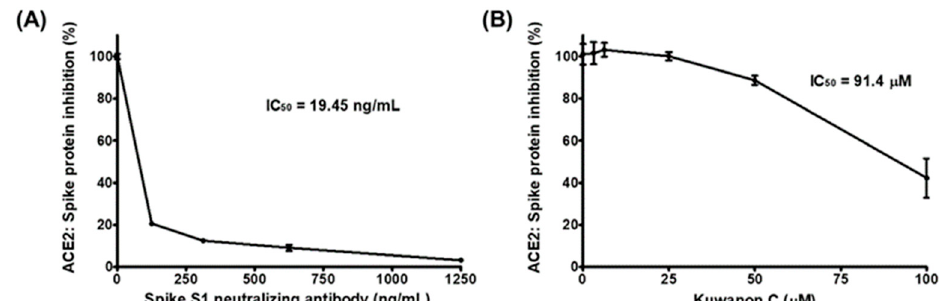
Figure 1. The inhibition of the interaction between the spike protein S1 receptor-binding domain (RBD) and the human angiotensin-converting enzyme 2 (ACE2) receptor by kuwanon C (KC). Spike protein coated on a 96-well plate interacted with a preincubated mixture of the ACE2 receptor and ( A ) anti-SARS-CoV-2 spike S1 antibody as the positive control and ( B ) 0, 3.125, 6.25, 12.5, 25, 50, or 100 µM KC. The inhibition of the spike S1 RBD:ACE2 receptor interaction by KC was determined based on chemiluminescence measurements.